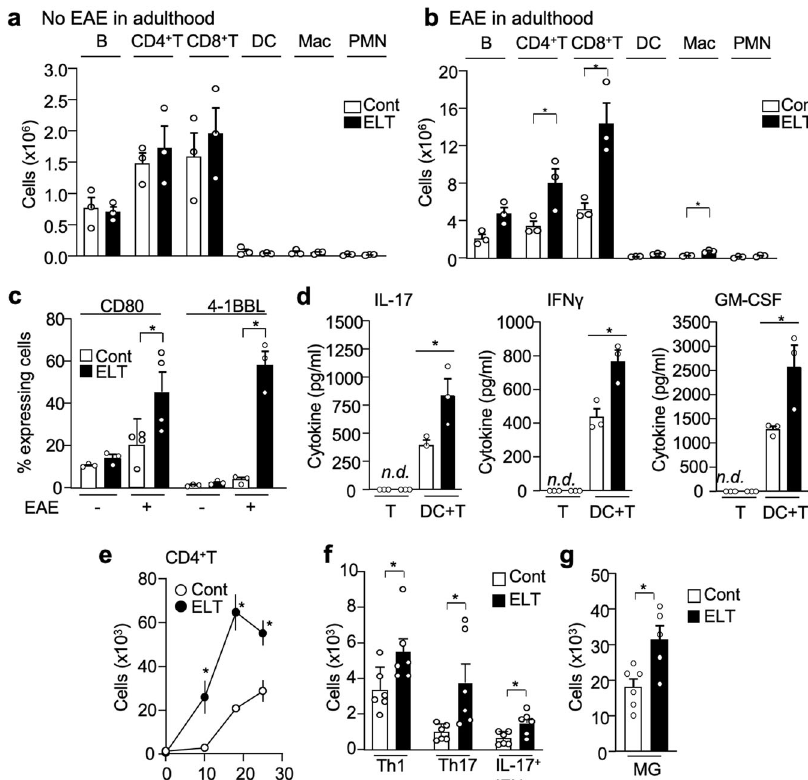
Fig. 2 ELT alters peripheral and CNS immune cell pro fi ling. a , b Absolute immune cell numbers (B cell: CD19 + , CD4 + T cell: CD3 + CD4 + , CD8 + T: CD3 + CD8 + , dendritic cell: CD11b + CD11c + , macrophage: CD11b + CD11c − , neutrophil: CD11b + Ly6G high ) in control and ELT mice without ( a ) and with ( b ) EAE. Cells were isolated from draining lymph nodes were isolated from EAE mice at 10 dpi ( n = 3 per group). c Percentage of co-stimulatory molecule (CD80 and 4-1BBL) expressing dendritic cells (CD80: n = 4 per group: 4-1BBL: n = 3 per group). d Amount of cytokines IL-17, interferon γ (IFN γ ), and GM-CSF in supernatant derived from culture conditions 72 h post culture initiation. CD4 + T cells were isolated from draining lymph nodes of ELT-EAE or control EAE mice on 10 dpi to be supplemented with MOG (10 μ g/ml) and cultured alone or with isolated dendritic cell isolated from ELT-EAE or control EAE mice ( n = 3 per group). White and black bars represent data from control and ELT conditions, respectively. e Absolute numbers of CD4 + T (CD45 + CD3 + CD4 + ) cells in spinal cord isolated from EAE mice on 0, 10, 18, and 25 dpi ( n = 5 per group). f Absolute numbers of IL-17 + -secreting CD4 + T (Th17), interferon γ + -secreting CD4 + T cells (Th1), and IL-17 + interferon γ + CD4 + T cells in the spinal cord of EAE mice at 25 dpi ( n = 6 per group). g Absolute numbers of microglia (MG: CD45 low CD11b + ) in the spinal cord at 25 dpi ( n = 5 per group). Each dot represents averaged data per animal. Data are represented as mean ± SEM. Two-tailed Student ’ s t -test, * P < 0.05. Exact P values for asterisks (from left to right): b 0.0497, 0.0172, 0.0050; c 0.0456, 0.0013; d 0.0478, 0.0164, 0.0470; e 0.005, 0.0004,